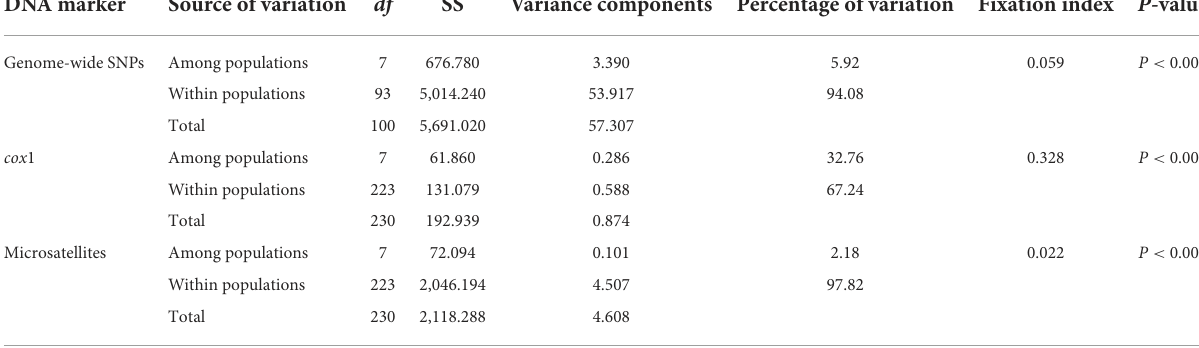
TABLE 4 Analysis of molecular variance (AMOVA) based on the three DNA markers of Ae. albopictus populations in China. DNA marker Source of variation df SS Variance components Percentage of variation Fixation index P -value Genome-wide SNPs Among